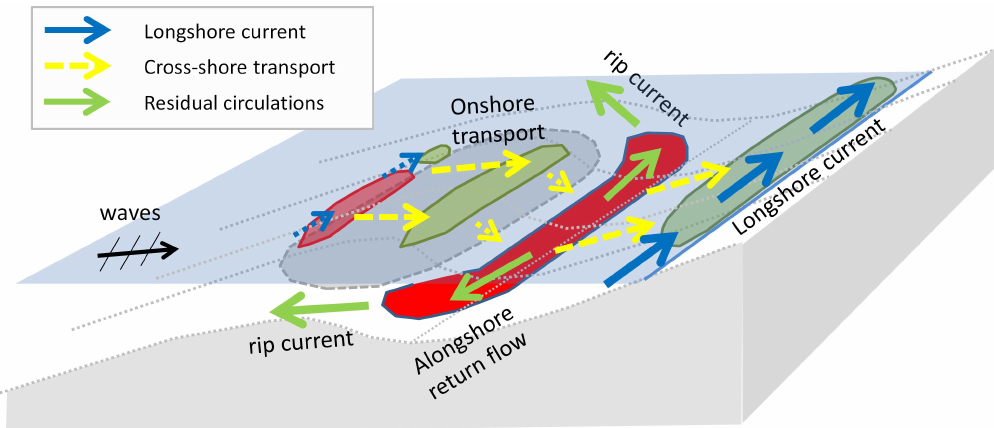
Figure 17. Illustration of mechanisms for sediment redistribution at shoreface nourishments. Areas with erosion and sedimentation of the bed shown are shown as red and green